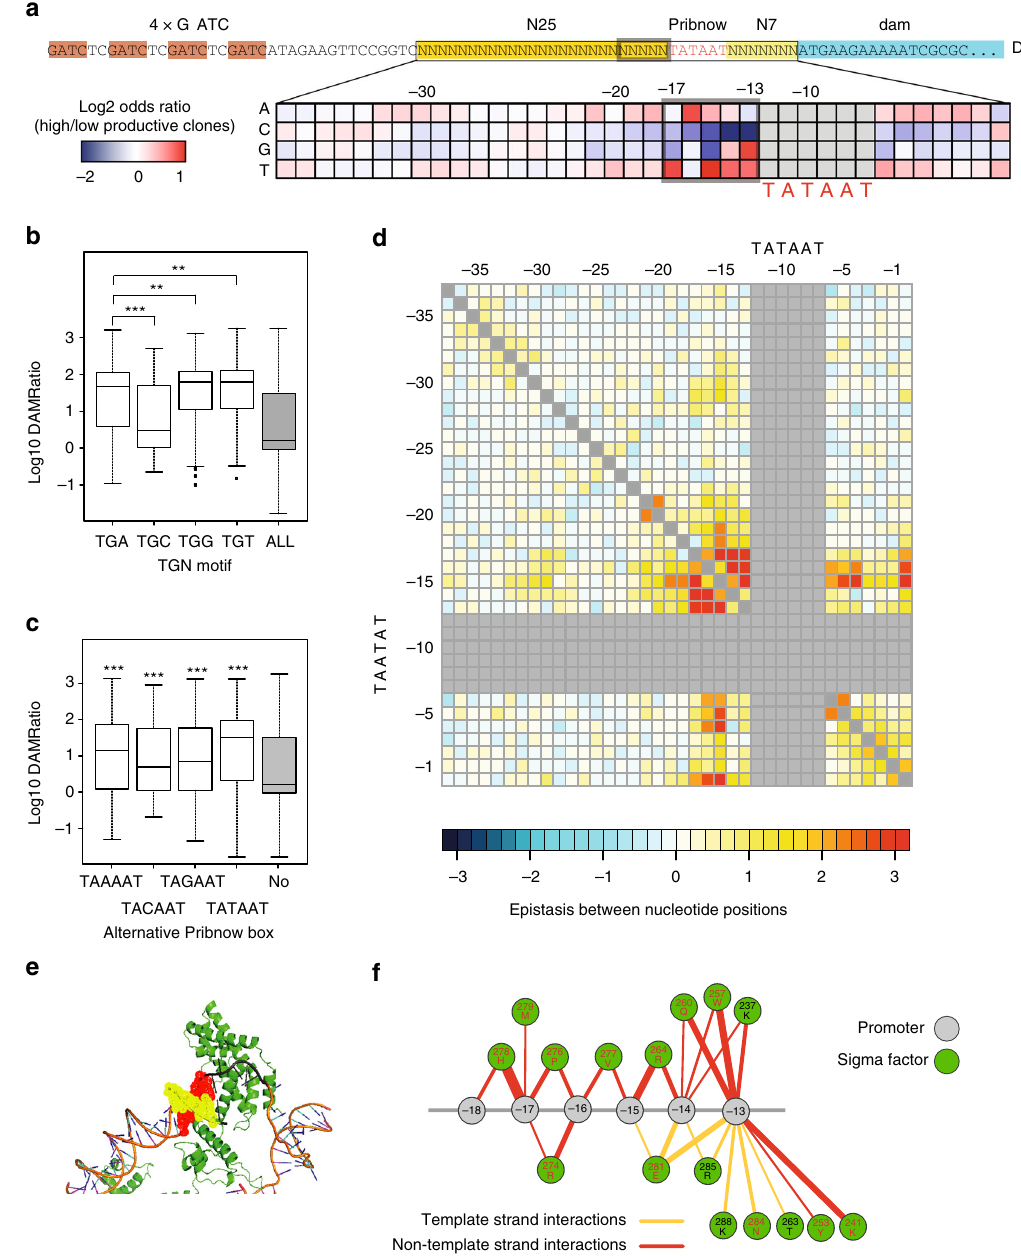
Fig. 3 Deep sequence analysis of the promoter region of M. pneumoniae . a N25 and N7 depict the randomized regions around the Pribnow sequence (TATAAT). Log2 odds ratio shows the nucleotide bases between high-productive and low-productive promoters. b DAMRatios for the TG motif (positions − 15 to − 14 upstream of the Pribnow box) with different bases at position − 13. *** P value less than 2 × 10 − 16 and ** P value is less than 1 × 10 − 4 . c The DAMRatios for additional alternative Pribnow motifs (TAAAAT, TACAAT, TAGAAT, and TATAAT) in the randomized promoters are signi fi cantly higher than the DAMRatio for having only one fi xed TATAAT Pribnow box. *** P value is less than 2 × 10 − 16 . d Matrix showing epistatic interactions between different bases of the randomized promoters. The promoter positions are from − 37 to +1. Positive values mean signi fi cant epistatic interactions compared to the null model. e Sigma factor-promoter complex structure of Thermophilus aquaticus (PDB: 4XLN). Domain 2 and domain 3 of sigma factor interacting with the DNA sequence upstream of the Pribnow box. The sequence similarity between the solved structure and sigA (MPN352) of M. pneumoniae is over 90%. Green color depicts sigma factor, and red and yellow dots represent the − 13 to − 17 regions of the non-template and template strands of the promoter, respectively. f Red and yellow edges represent the interactions between sigma factor and the non-template and template strands of the promoter, respectively. Edge widths correspond to the number of atomic contacts ( > 5 Å). The − 13 to − 15 regions of both the template and non-template strands of the promoter interact with sigma factor. Red font represents the residues that are identical to the aligned sequence of the sigma factor of M. pneumoniae. P values were calculated with a two-tailed t